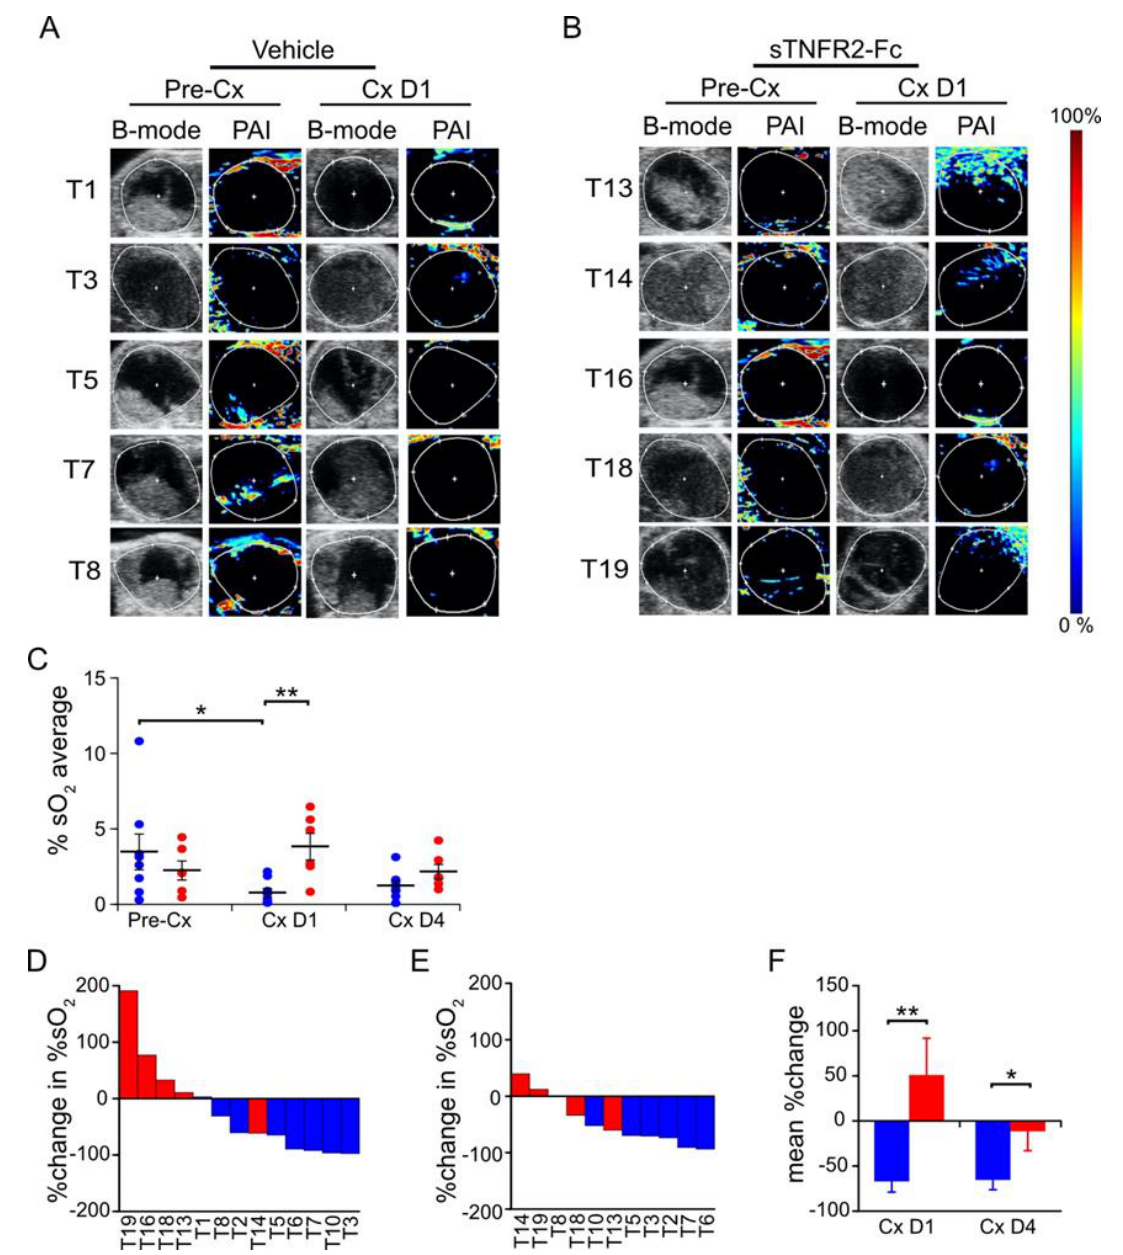
Figure 5. Castration-induced hypoxia is reversed by TNF blockade in prostate tumors of PbCre4 × Ptenfl/fl mice. ( A , B ) Photoacoustic images (PAI, pseudo-colored) and ultrasound (B-mode) of five tumors pre- and one day post-castration from vehicle-treated mice ( A ), or sTNFR2-Fc-treated mice ( B ). ( C ) Intra-tumoral mean PAI intensity (%sO 2 Average) pre-castration, and at one and at four days post-castration in vehicle-treated (n = 8, 8, 7 respectively, blue) or in sTNFR2-Fc-treated (n = 6, 5, 4 respectively, red) mice. ( D ) Waterfall plot of change in intra-tumoral %sO 2 one day after castration in mice treated with sTNFR2-Fc (red) or vehicle (blue). ( E ) Waterfall plot of change in intra-tumoral %sO 2 four days after castration in mice treated with sTNFR2-Fc (red) or vehicle (blue). ( F ) Change in paired measures of intra-tumoral %sO 2 pre-castration versus D1 or D4 after castration. Mean (columns or lines) and SEM (bars). * p < 0.05, ** p < 0.01.